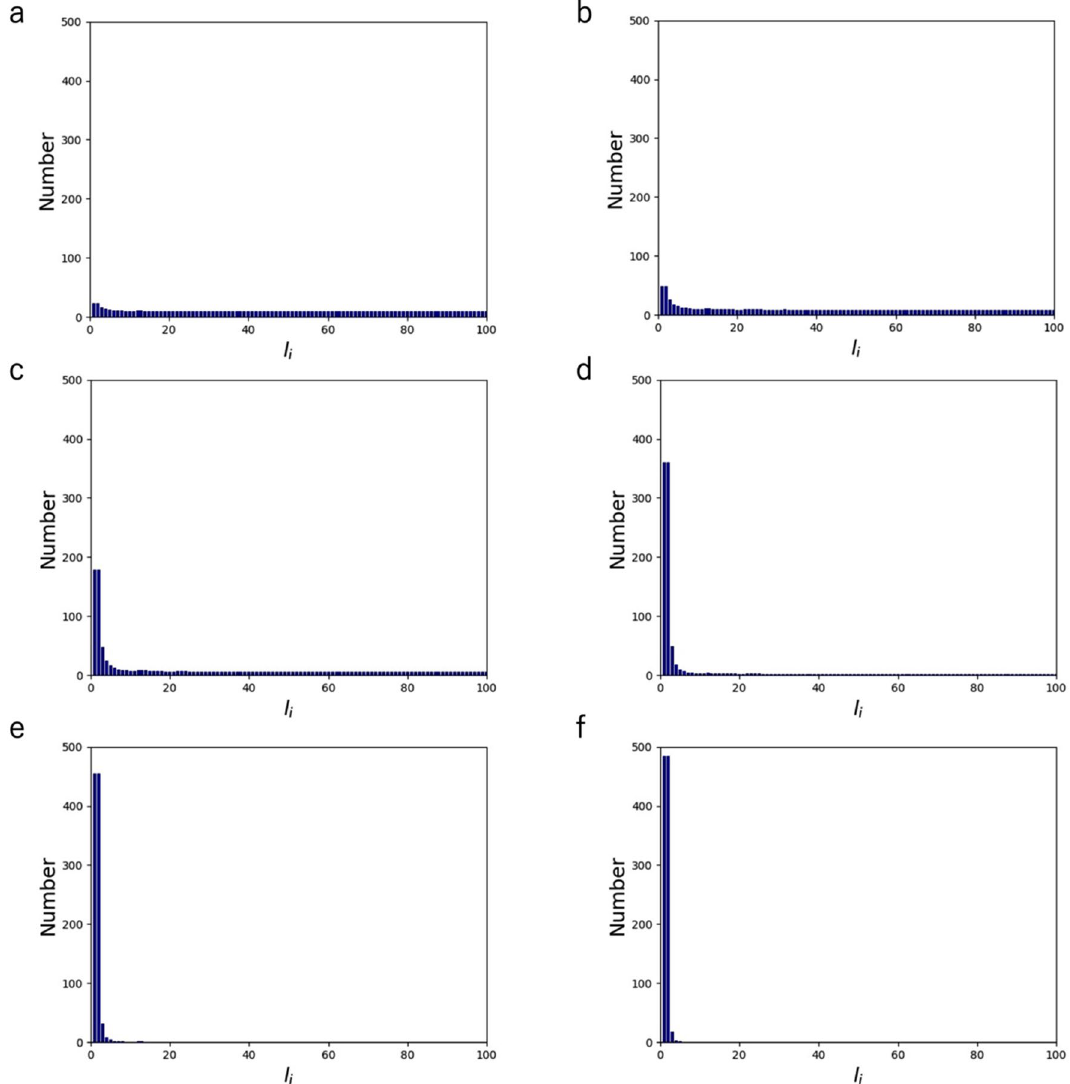
′ k b = 1 ( a ), k ′ k b = 2 ( b ), k ′ k b = 4 b / b / b / k b , populations of AFs with shorter lengths b /